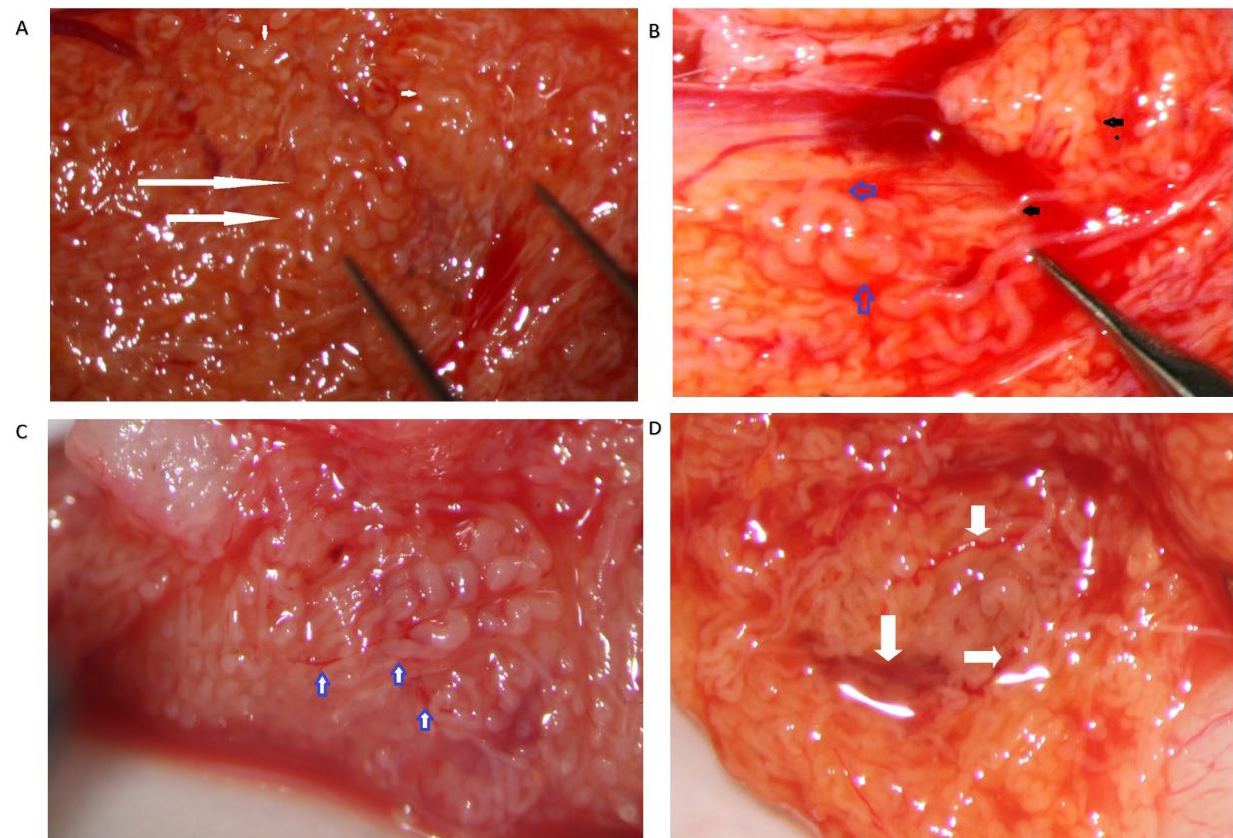
Figure 4. Dilated tubules. ( A ) Medium-sized group of dilated tubules (long arrows) among not-dilated tubules of different caliber. ( B ) Small group of dilated tubules (blue arrows) dispersed among non-dilated tubules (black arrows). ( C ) A small lobule of dilated tubules crossed and flanked by tiny blood vessels (arrows). ( D ) A group of large opaque tubules surrounded by blood vessels (arrows).